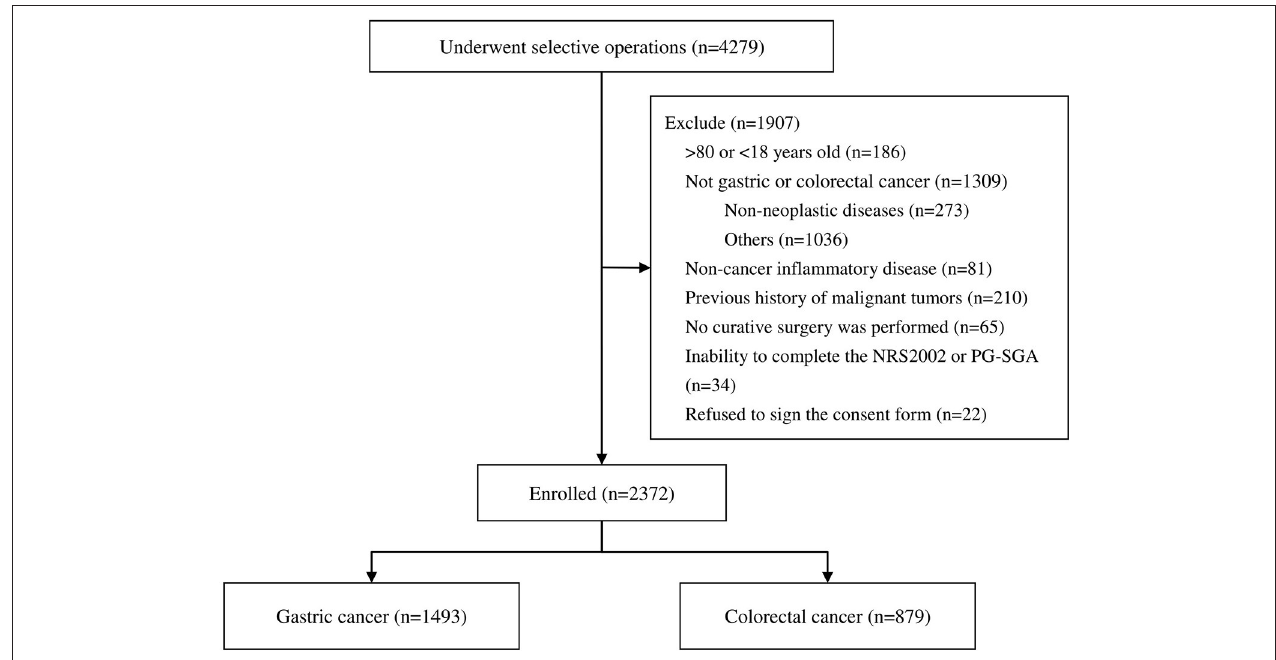
FIGURE 1 | Diagram of patient enrollment in the